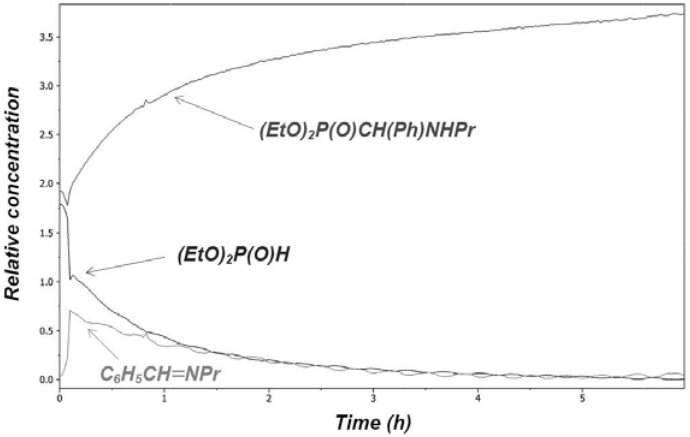
Figure 1. Concentration profile for the Kabachnik–Fields reaction studied at 80 °C in